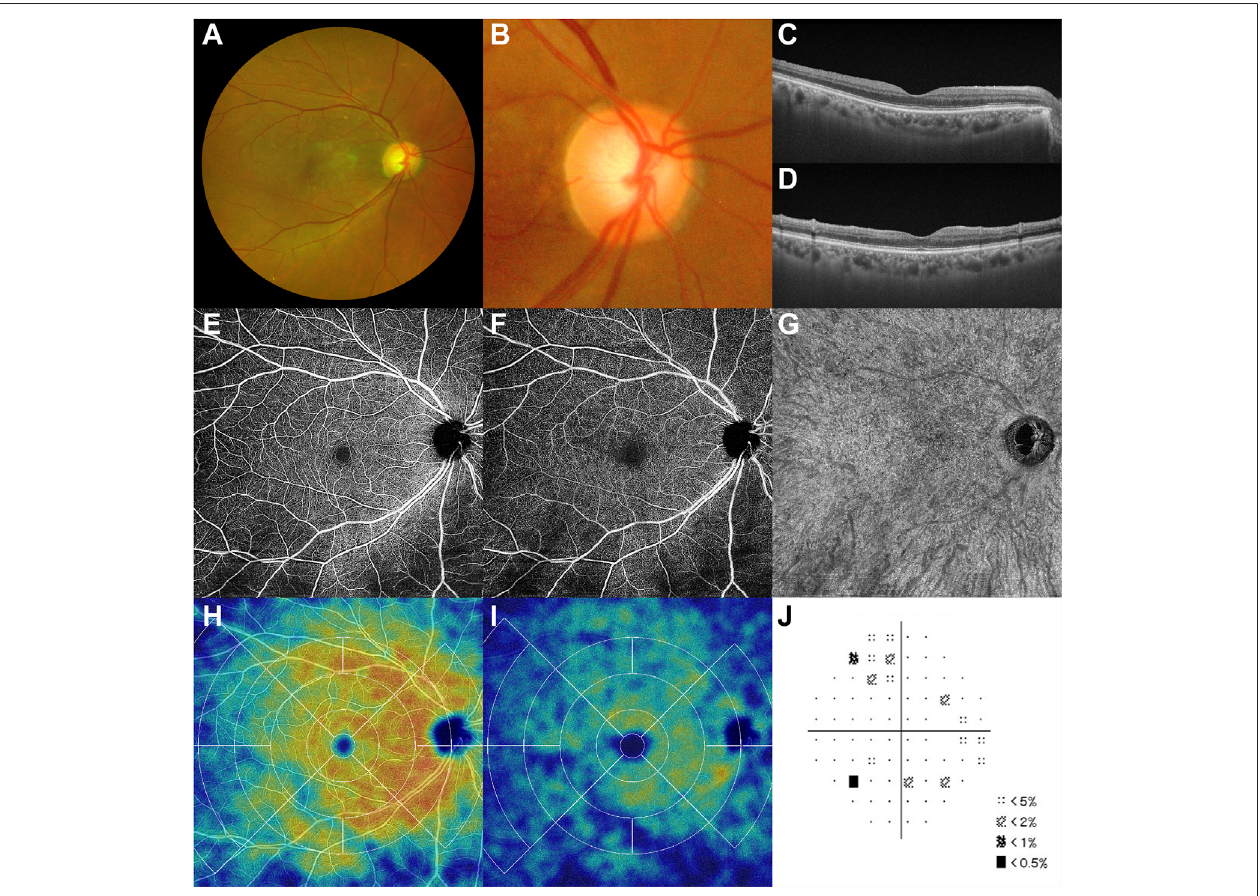
FIGURE 4 | Follow-up multimodal images after treatments and the second dose of the SARS-CoV-2 mRNA vaccine (A,B) With recanalization and degraded microthrombi, macular ischemia disappears, and the color of the upper macula turns to normal on day 30 post- fi rst vaccination. (C – G) Decorrelation signals from SCP and DCP revivewith mitigated inner retinal edema, and choroidal vasculature is intact. (H,I) Upper macular perfusion increases in both SCP and DCP. (J) Along with the anatomical improvements, inferior visual fi elds recover partially. DCP, deep capillary plexus; SCP, super fi cial capillary plexus.